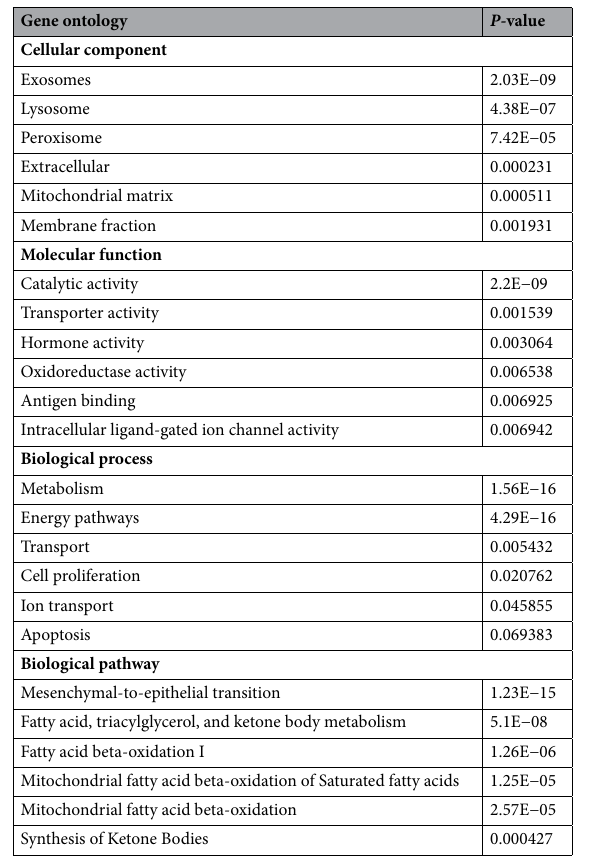
Table 5. Blue module functional enrichment results. www. kegg. jp/ kegg/ kegg1.